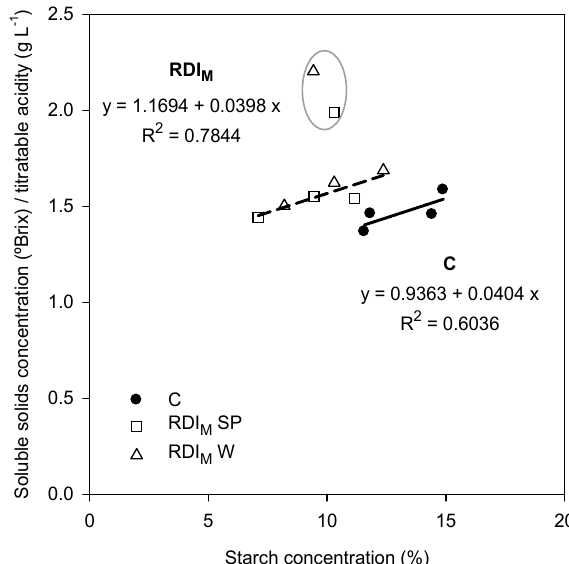
Figure 7. Relationship between the starch concentration in post-harvest 2015 and the soluble solids concentration by the titratable acidity in 2016. The observations inside the grey oval were outliers removed from the RDI M linear regression.